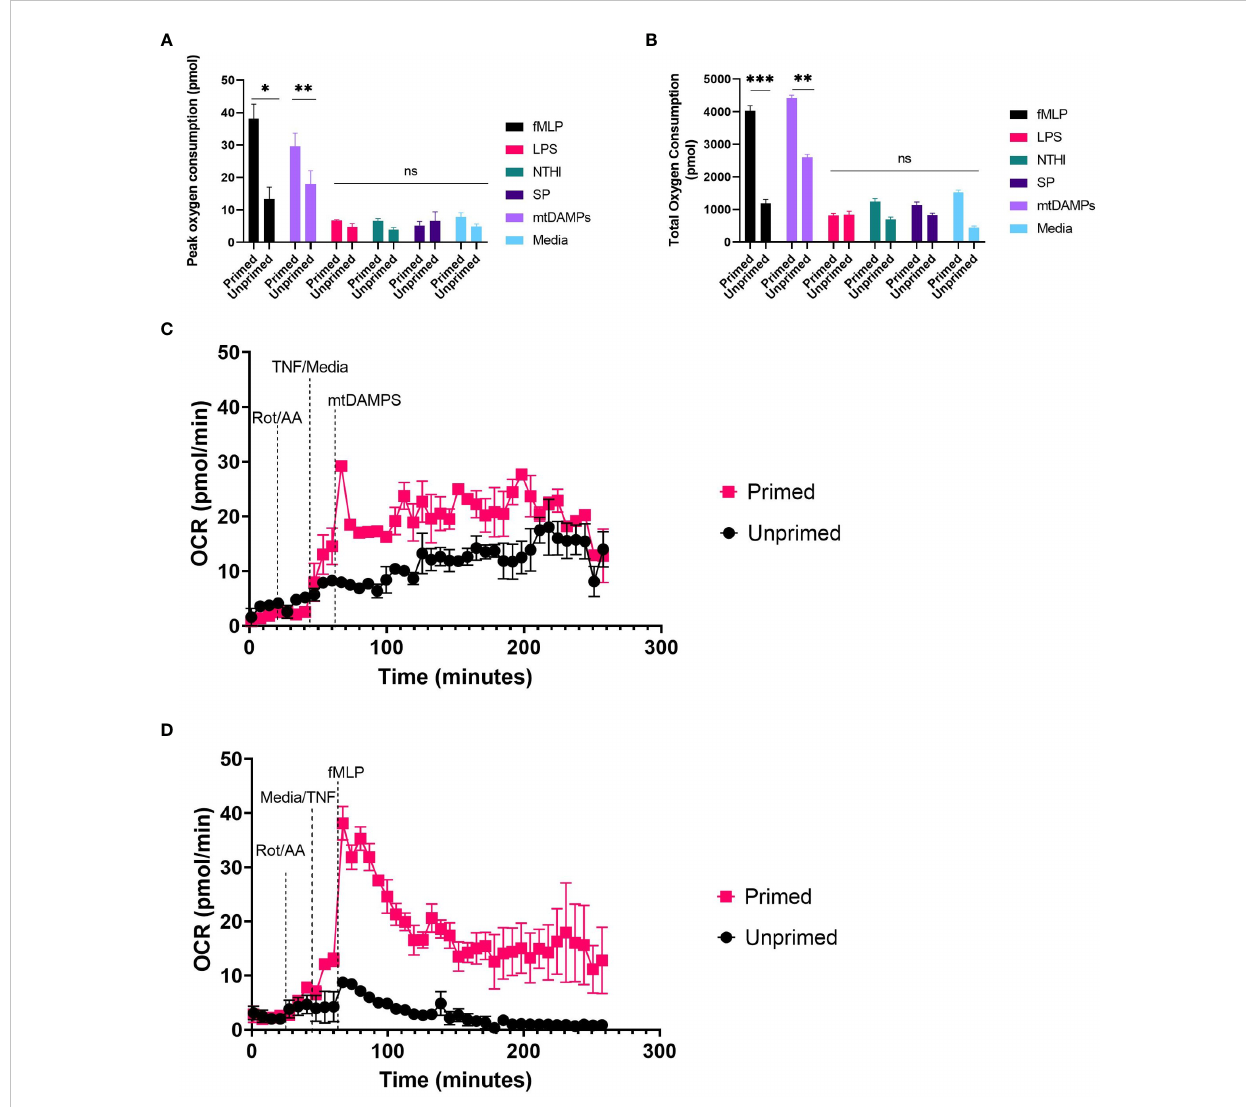
FIGURE 4 Induced OCR from activated neutrophils. Human peripheral blood neutrophils were seeded at 5 x 10 4 cells/well onto Cell-Tak ™ coated XF XFe96 microplates. Oxidative burst was probed by sequential injection of 2 µM rotenone plus 2 µM antimycin A, 10ng/ml TNF a (primed), or XF media (unprimed) followed by 10µM fMLP, or 10µm LPS, NTHI at 100 bacteria:1 neutrophil, SP at 100 bacteria: neutrophil or 100µg/ml mtDAMPS.